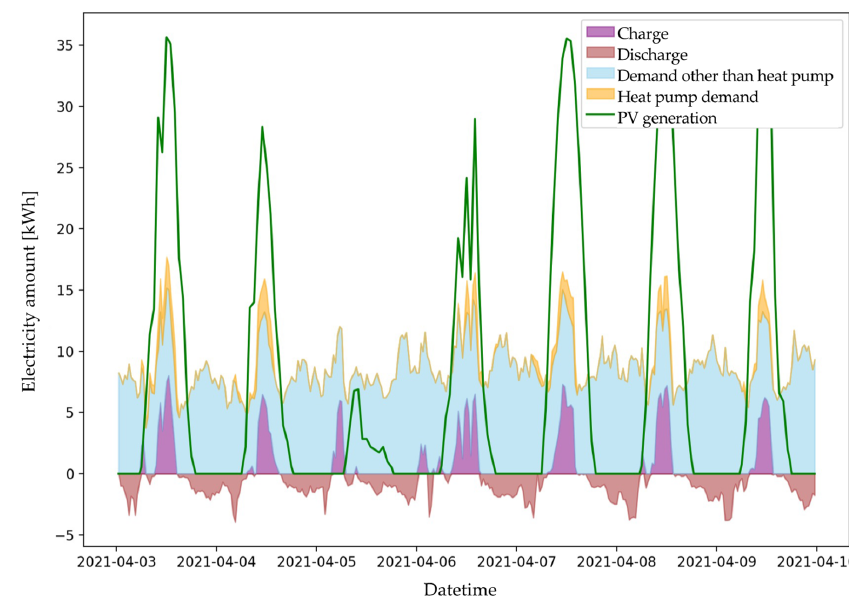
Figure 13. Demand changes for one week with P2P transactions (Scenario 1).